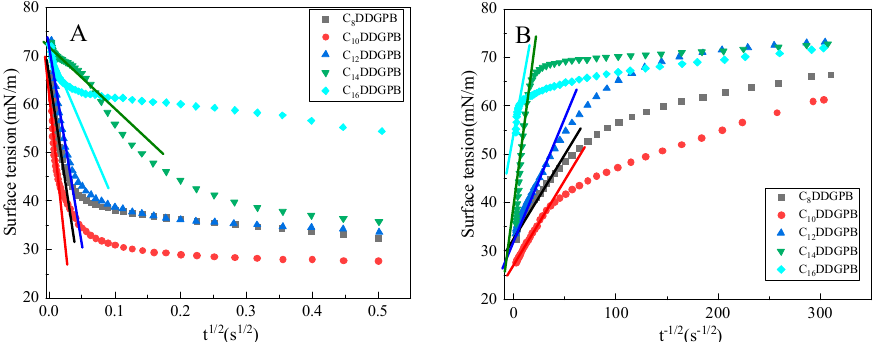
Figure 4. Relationship of the dynamic surface tension of a C n DDGPB surfactant aqueous solution with time ( A ) t 1/2 , ( B ) t − 1/2 . (The concentration of the surfactant solution was 5 mmol/L).